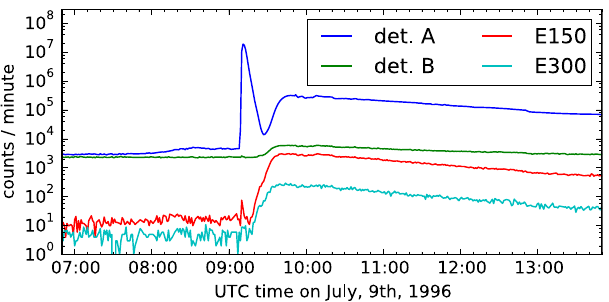
Fig. 5. One minute resolution count rates of the electron channels E150 (red), E300 (teal), the single detectors A (blue) and B (green) on July